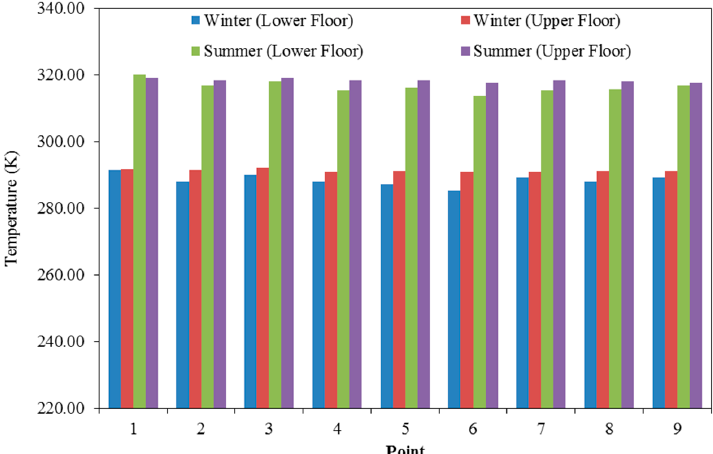
Figure 19. Comparison of the airflow temperature distribution inside the dome house during winter and summer (buoyancy driven flows).